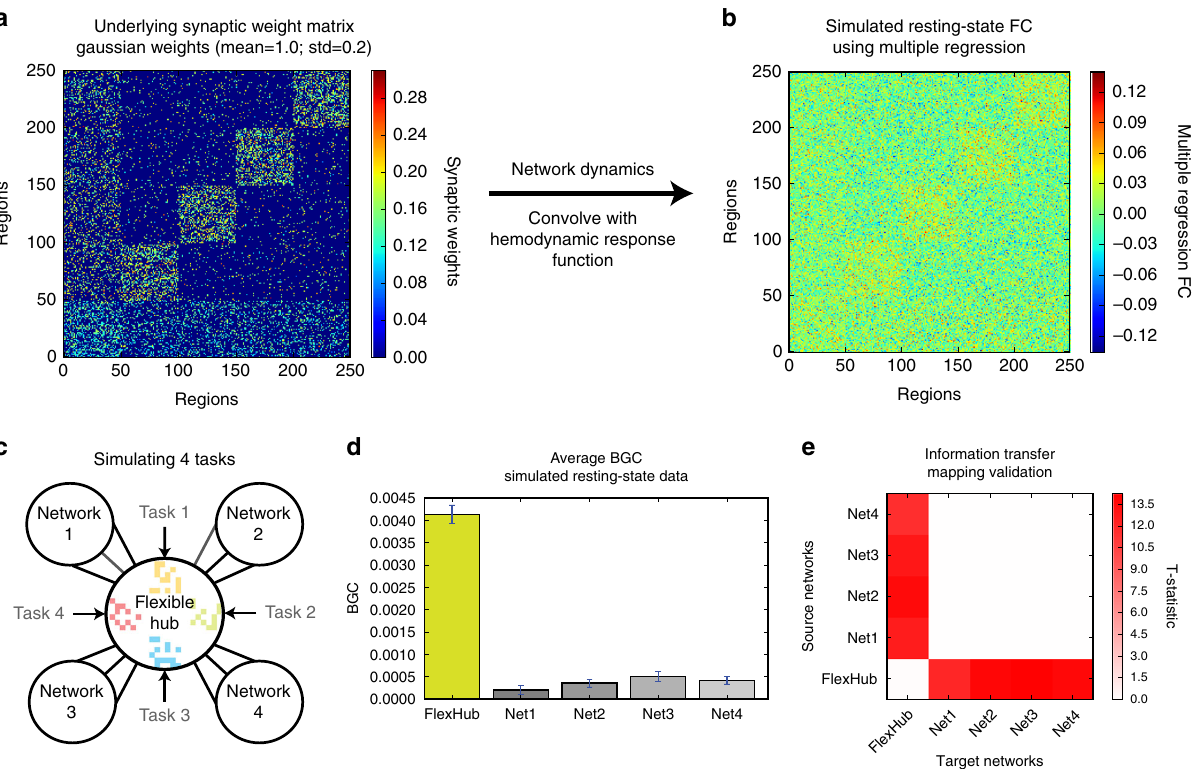
Fig. 4 Computational validation of network-to-network information transfer mapping. a Underlying synaptic weight matrix with four local networks and one hub network. We constructed an abstract neural network with a single hub network to see the relative effect of information transfer from the hub network to downstream local networks, similar to the hypothesized computational function of the cognitive control networks during task. b Recovering large-scale synaptic organization via multiple regression FC estimates on a simulated resting-state time series. c We simulated four ‘ cognitive control tasks ’ by stimulating four distinct ensembles of regions within the hub network. d Increased BGC estimated at rest re fl ects underlying synaptic organization. Error bars represent across-subject standard error. e Thresholded information transfer estimates between pairs of networks in a neural network model. Each row in the matrix corresponds to a source network from which we mapped activation patterns to other target networks using the information transfer mapping procedure (Fig. 1c). Each column in the matrix corresponds to a target network to which we compared the predicted-to-actual activation patterns. FWE- corrected thresholded T-statistic map with p <